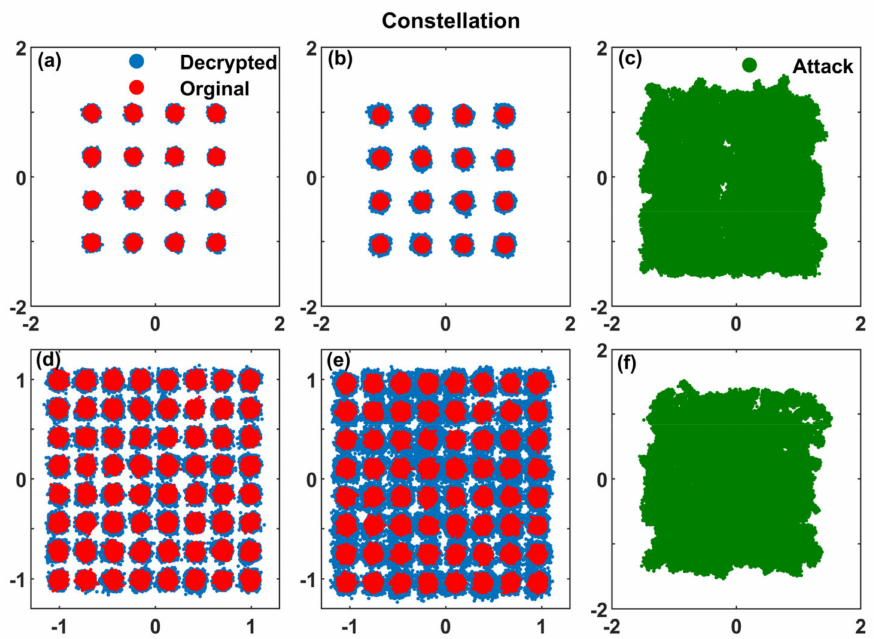
Figure 5. Constellations of the original, decrypted ( a – c ) Message 1 and ( d – f ) Message 2 transmission in ( a , d ) 10 km (first column), ( b , e ) 20 km (second column) optical fiber and ( c , f ) attack (third